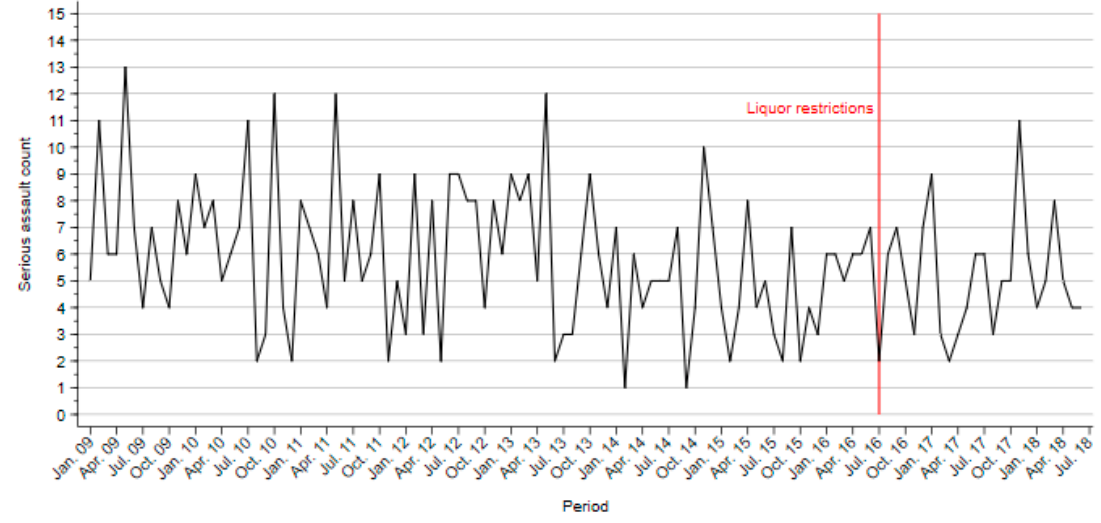
Figure 2. Serious assaults in local government areas with venues only affected by liquor restrictions during high-alcohol hours .